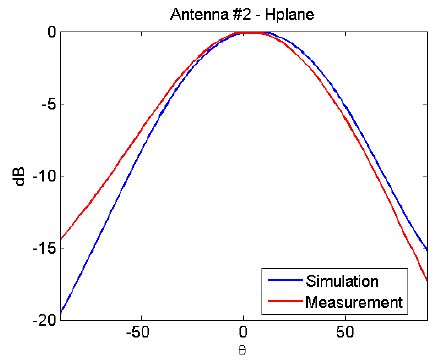
Figure 7. Comparison between measurements and simulations for antenna configuration (cid:93) 1 (upper right patch “OFF”)—H plane.